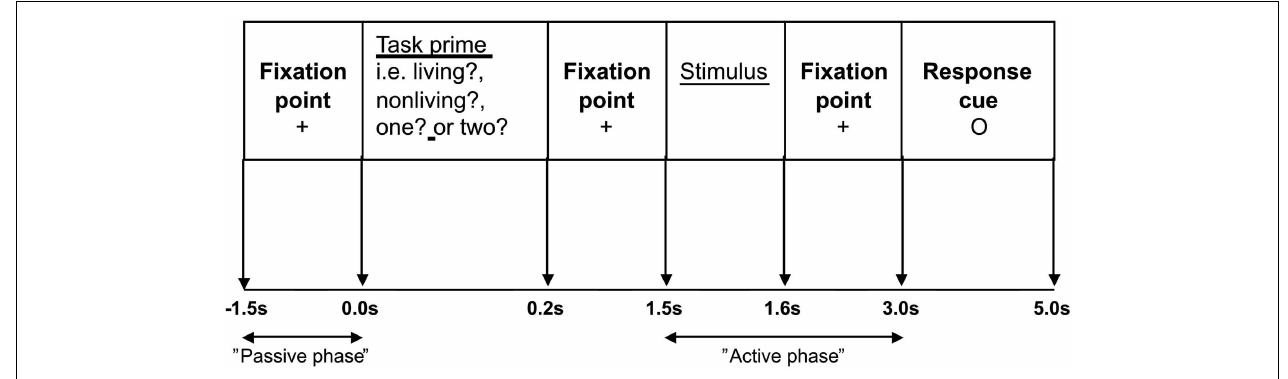
was then presented for 0.1s, the fixation cross was shown for 1.4s before the response cue (a small circle in the center of the screen) was displayed for